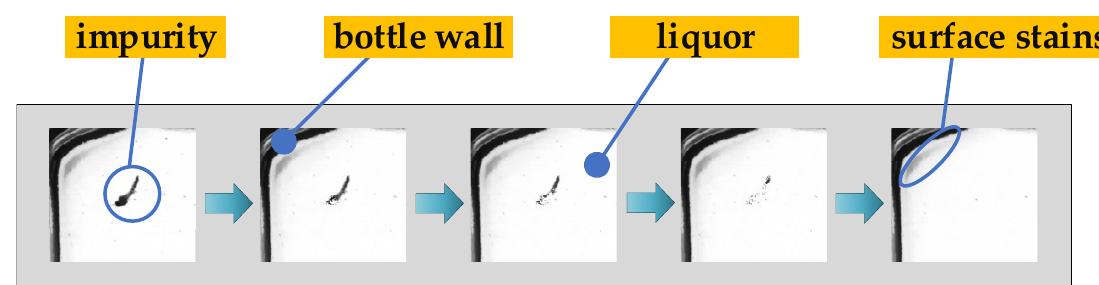
Figure 14. Background convergence process of the adaptive GMM fusion frame difference. The experimental video was divided into three frame segments: start, run and end.